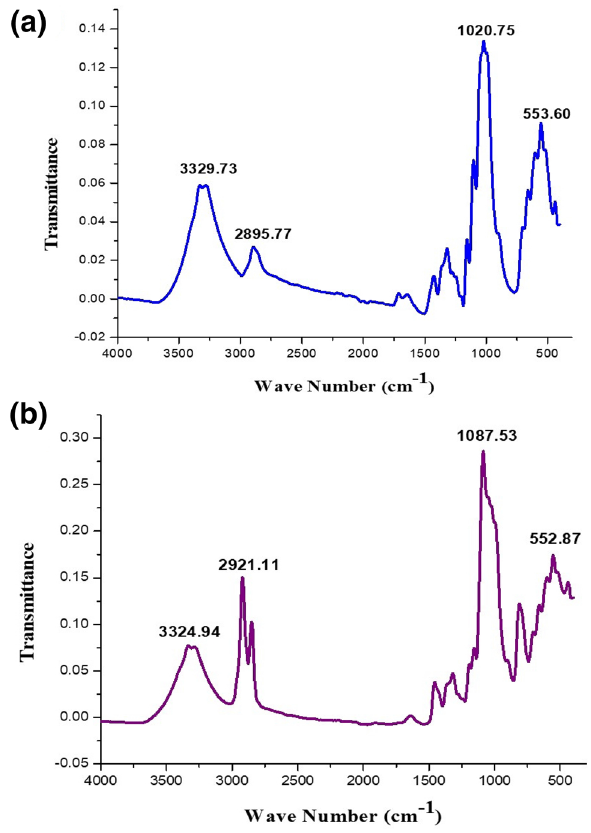
Fig. 5 FTIR spectra of a control nonwoven cotton fabric, b HDTMS- treated nonwoven cotton fabric